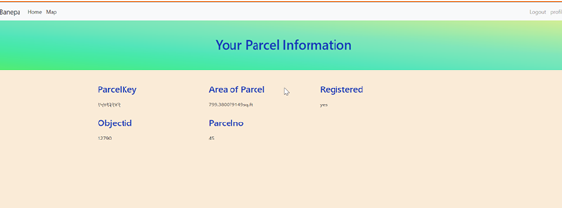
Figure 9. Viewing information by authentic